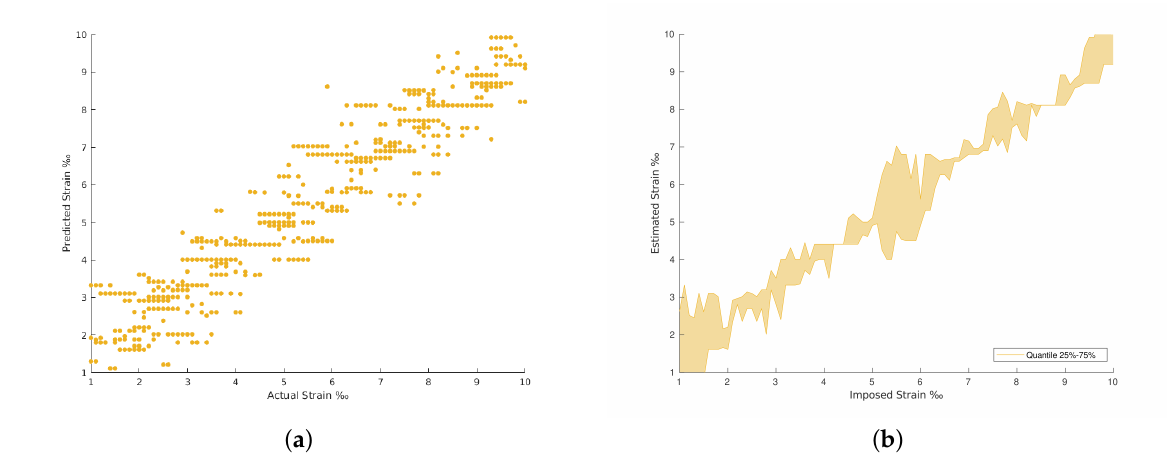
Figure 11. Support Vector Regression (SVR) results. ( a ) Support Vector Regression predictions. ( b ) Support Vector Regression predictions by quantile